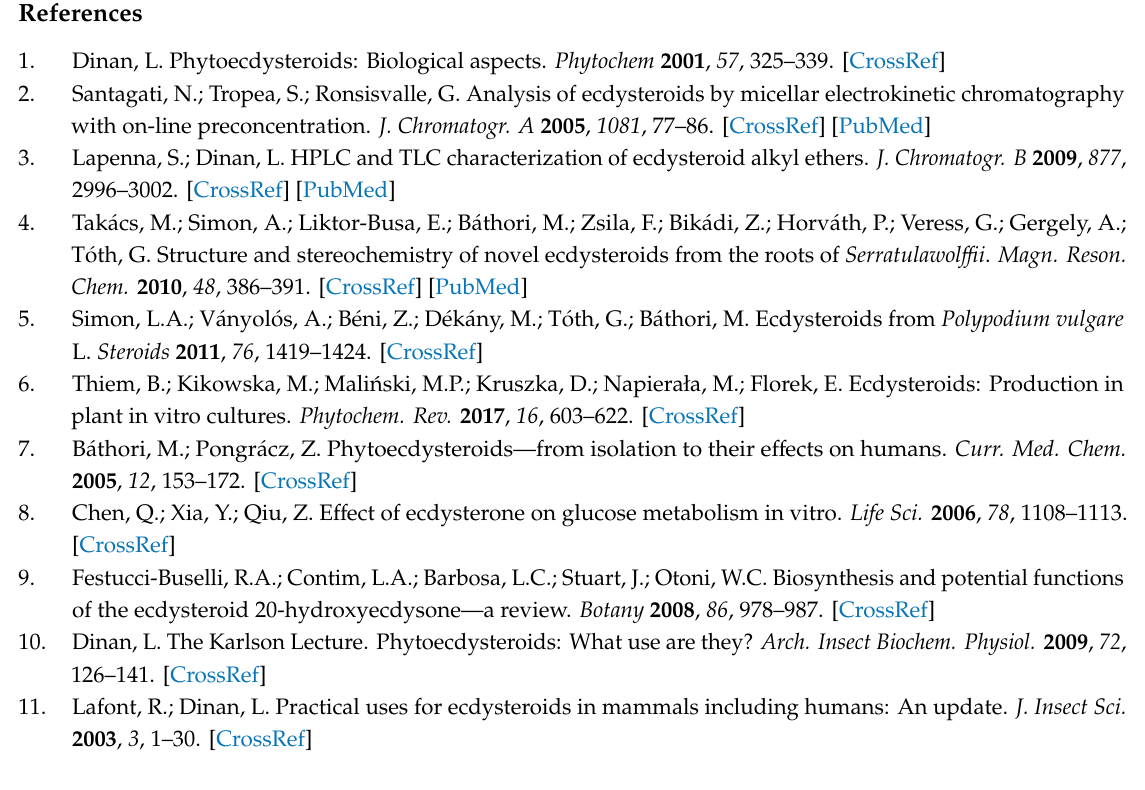
Figure S1: 1 H NMR (600 MHz, CD 3 OD) spectrum of compound 1 , Figure S2: 1 H NMR (600 MHz, CD 3 OD) spectrum of compound 2 , Figure S3: 1 H NMR (600 MHz, CD 3 OD) spectrum of compound 3 , Table S1: 1 H NMR data (600.20 MHz) of ajugasterone C ( 1 ), polypodine B ( 2 ) and 20-hydroxyecdysone ( 3 ) (in CD 3